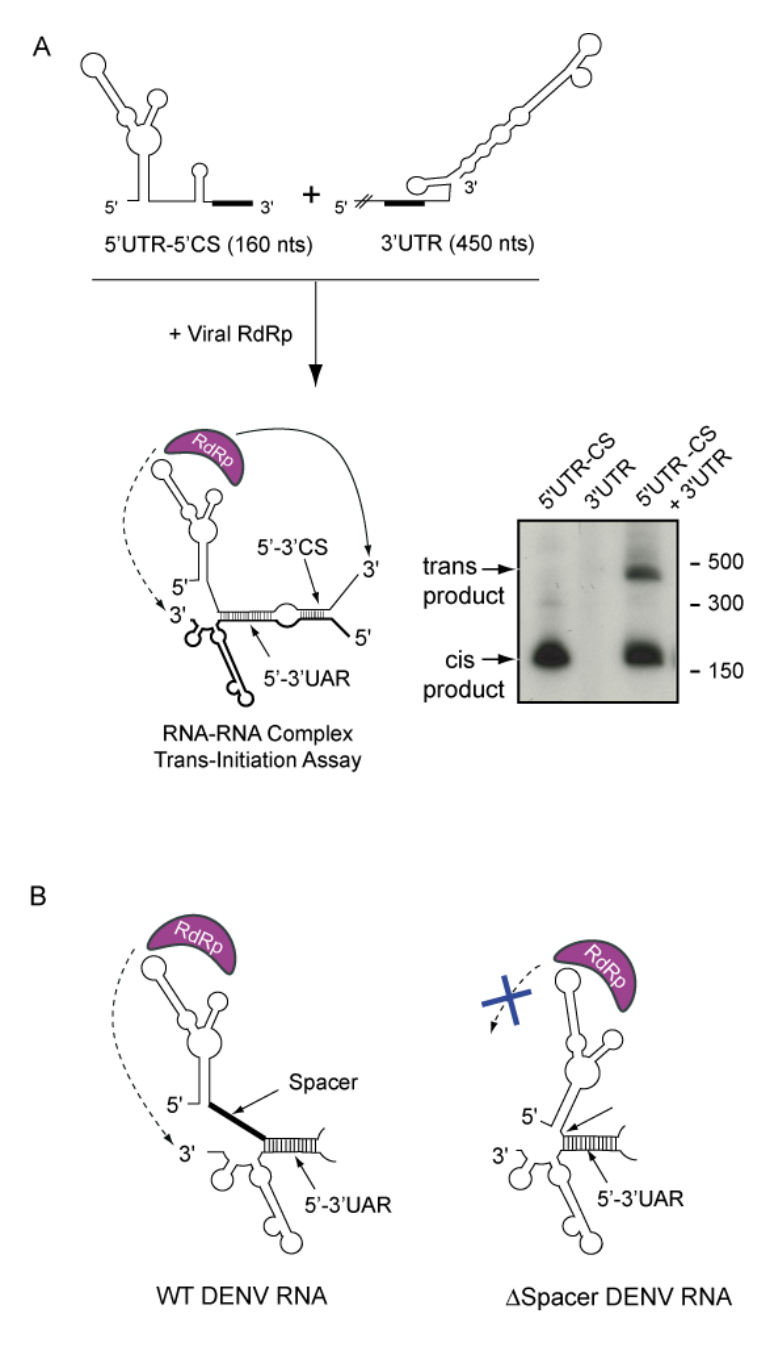
Figure 3. Representation of the in vitro trans initiation assay for RNA synthesis. ( a ) Formation of an RNA-RNA complex between the first 160 nucleotides of the viral genome (5'UTR-5'CS) and the viral 3'UTR allows the RNA-dependent RNA polymerase (RdRp) to initiate RNA synthesis at the 3' end of both molecules, as indicated schematically in the figure. On the right, a representative native polyacrylamide gel shows the radiolabeled RNA products obtained after incubation of the viral RdRp with the templates described at the top of the figure. ( b ) Schematic representation of the role of a spacer sequence for RNA synthesis. The oligo(U) track spacer located between the SLA and the hybridized 5'-3' UAR sequences allows accommodation of the RdRp to initiate RNA synthesis at the 3'UTR. In contrast, an RNA molecule carrying an intact SLA but a deletion of the oligo(U) spacer is unable to promote RNA synthesis in trans